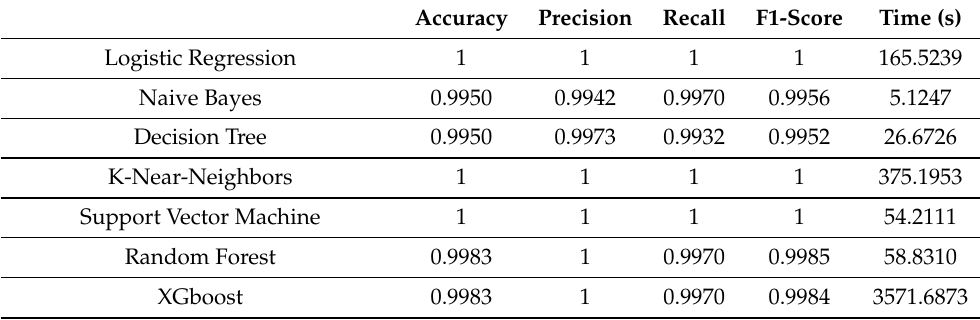
Table 1. Detection performance of identifying different attacks target smart lamp scenario.